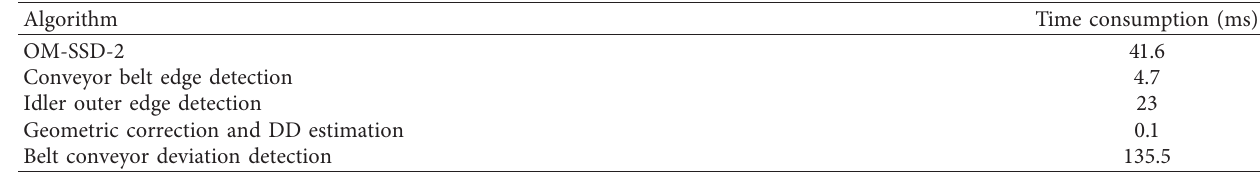
Table 6: Time consumption of the proposed